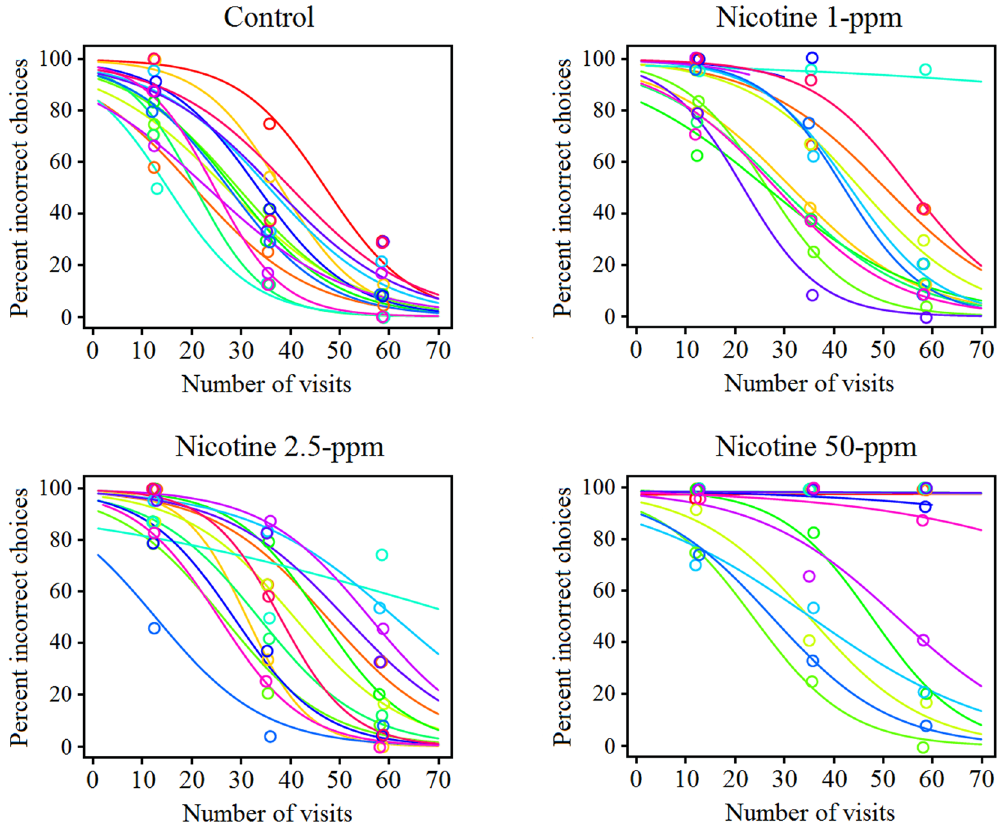
Figure 4. Individual bee performance in the reversal learning test. Plot of individual bee performance ( n = 60) in the reversal learning test in which the rewarding and unrewarding flower colours were switched with respect to the forward learning phase, and the rewarding flower for all groups provided sucrose solution (without nicotine). For each bee ( n = 60) 70 consecutive visits were recorded ( x -axis). Different colours represent different individual bees. Circles represent raw data of bee choices that were pooled to 3 large bins of sequential choices for clarity. Curves were fitted to the 70 visits completed by individual bees. The plots reveal the large variation among individual bees’ responses. Some bees were unaffected by nicotine but an increasing number of bees were very slow or completely failed to revert with increasing nicotine concentration encountred in the forward learning